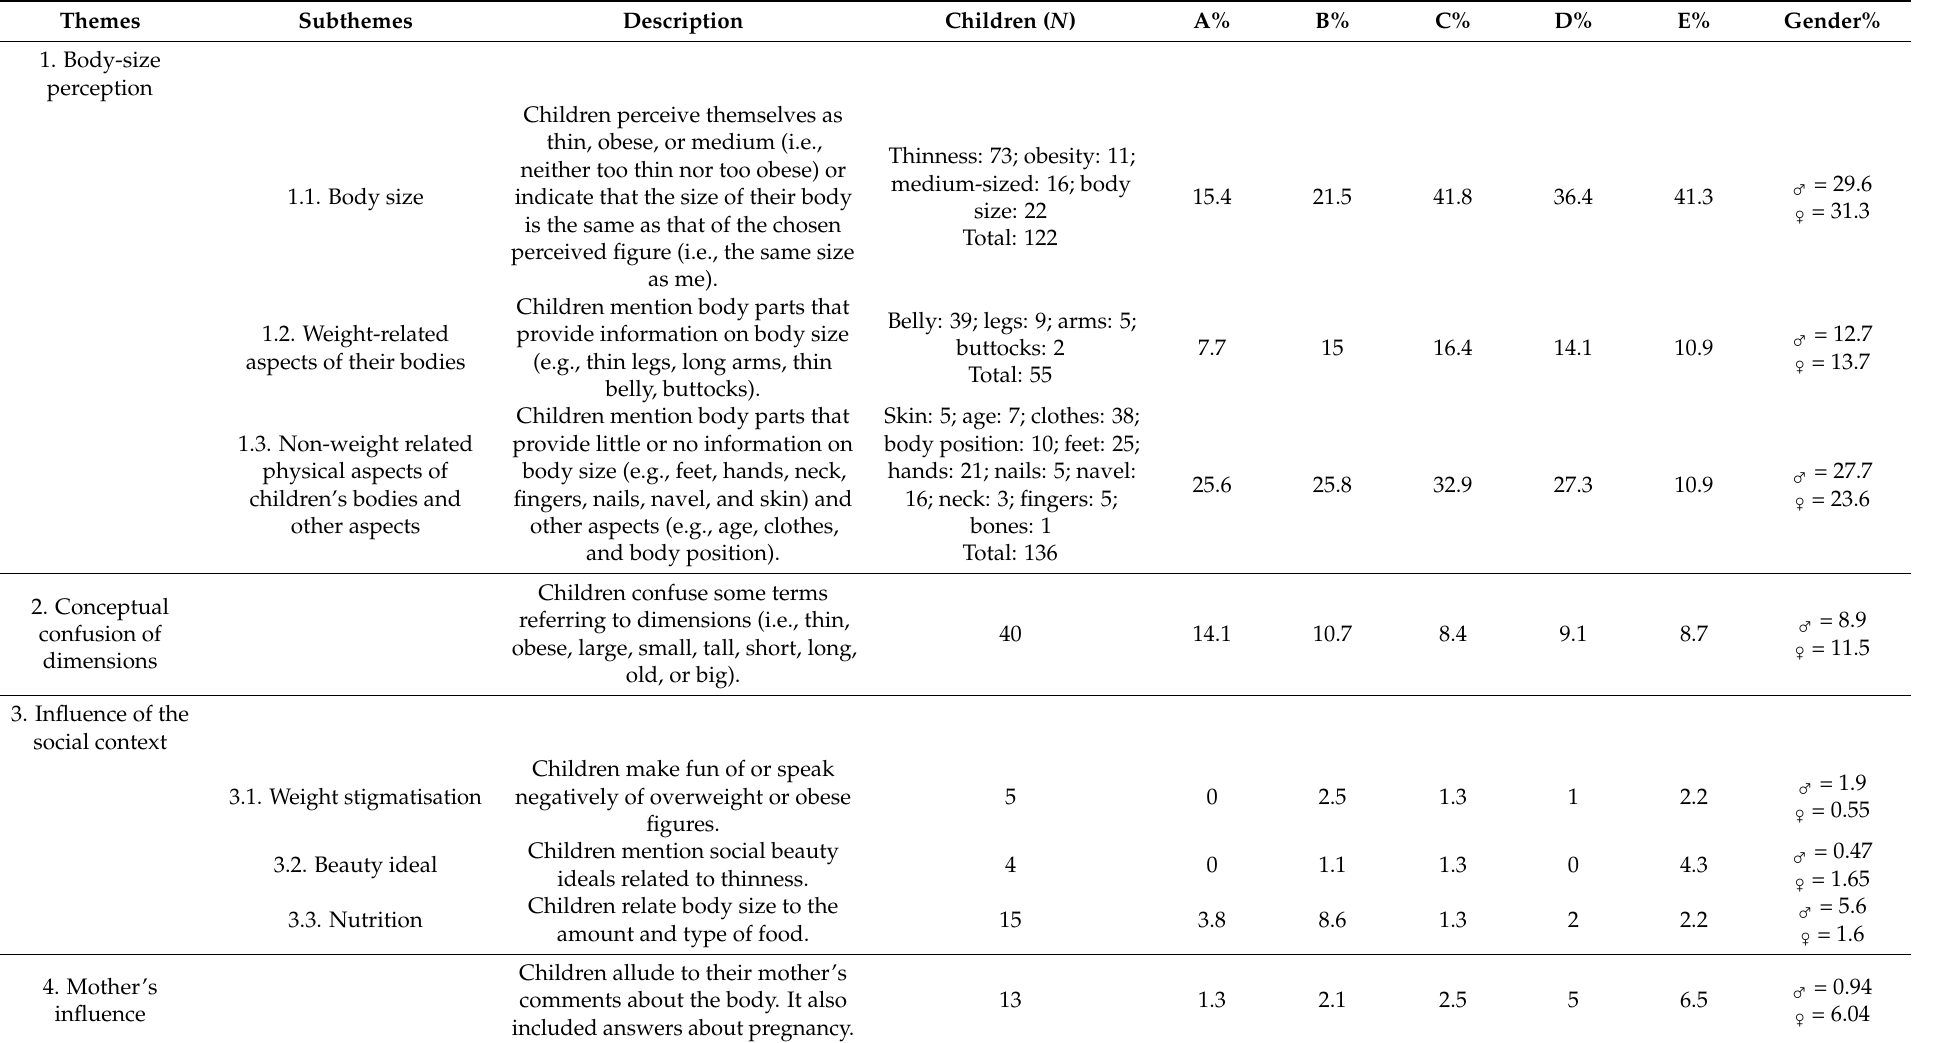
Table 3. Description of themes and subthemes. Frequencies and percentages of themes according to age group and gender, including responses from perceived and ideal bodies.